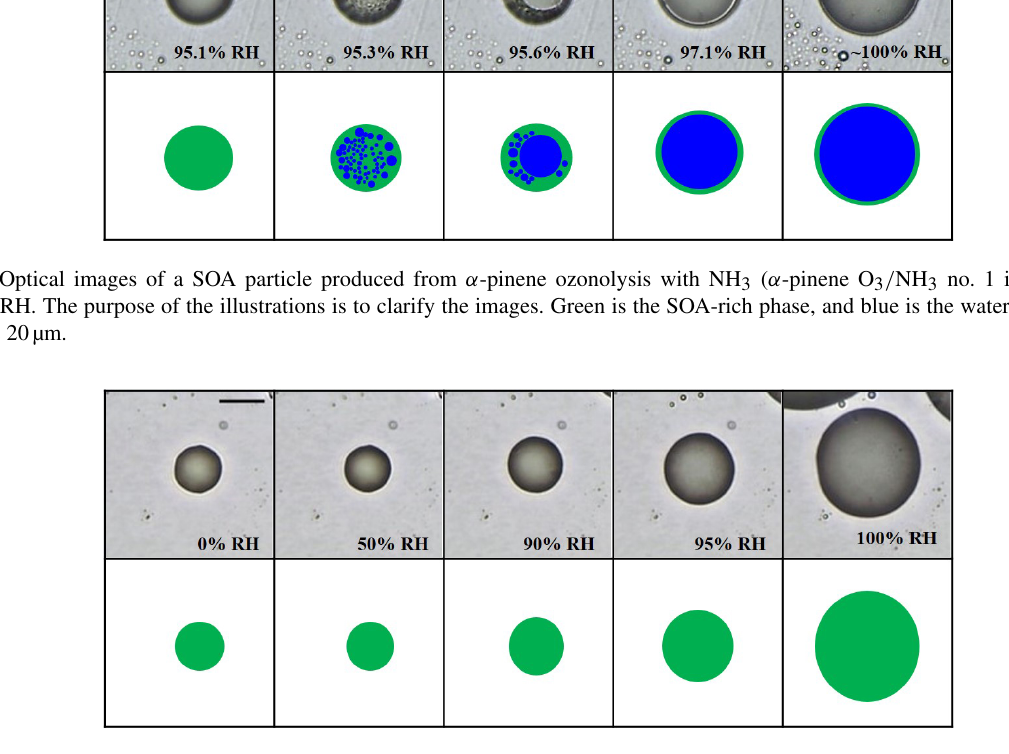
Figure 4. Optical images of a SOA particle produced from α -pinene photooxidation with NH 3 ( α -pinene OH / NH 3 no. 2 in Table 1) with increasing RH. The purpose of the illustrations is to clarify the images. Green is the SOA-rich phase, and blue is the water-rich phase. The scale bar is